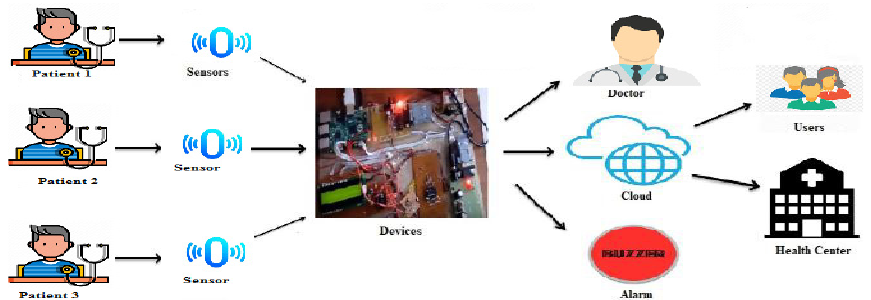
Figure 1. IOHT concept